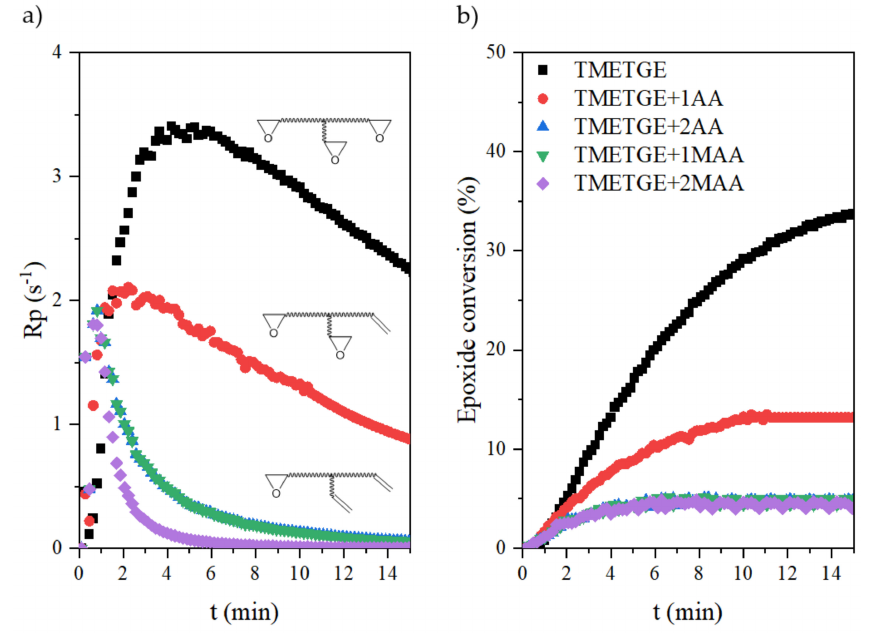
Figure 11. The photopolymerization rate ( a ) and the epoxide conversion ( b ) curves of the epoxy (meth)acrylates.